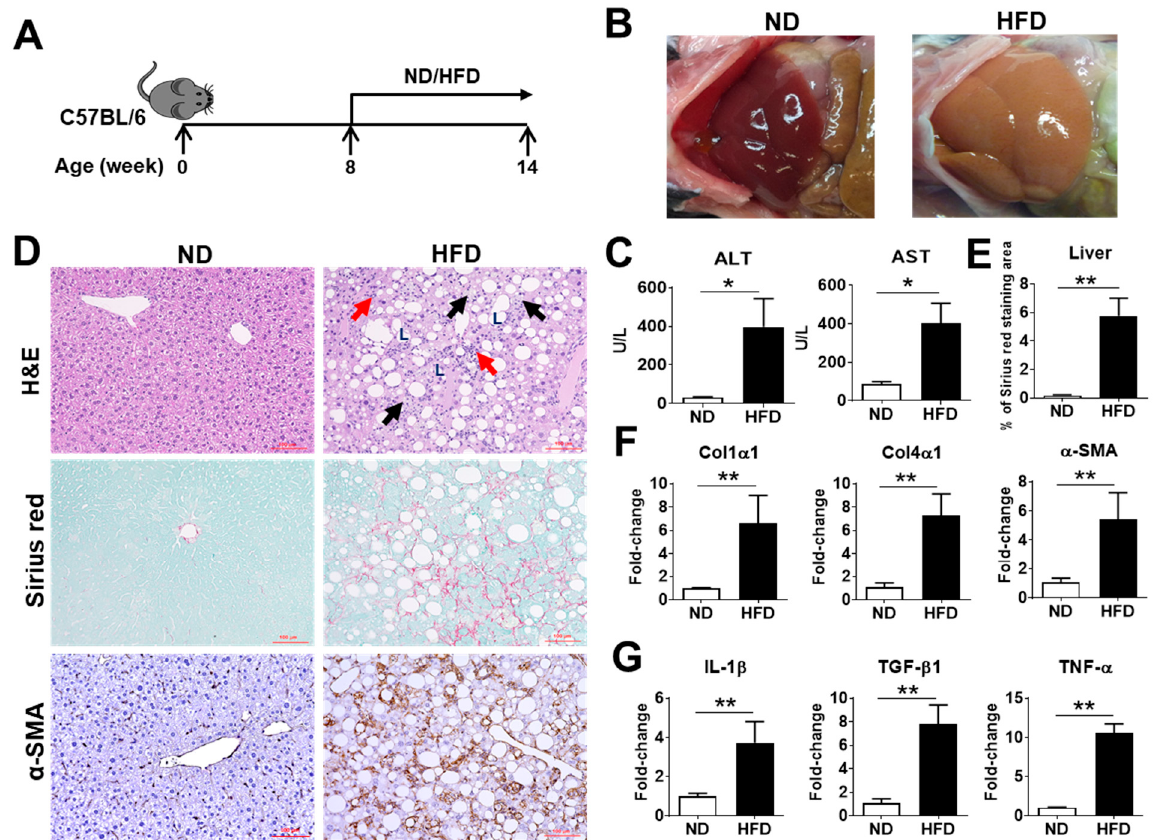
Figure 2. Characterization of a mouse NASH model. ( A ) An outline depicting HFD-induced mouse NASH. Eight-week-old wild-type (WT) C57BL/6 mice were fed a CDAHFD (abbreviating to HFD in the figures) for 6 weeks. Normal diet (ND) was used as a control. At week 14, each mouse was euthanized for the following studies. ( B ) Representative macroscopic images of livers in mice fed with HFD and ND. ( C ) Serum levels of ALT and AST in mice fed with HFD and ND. ( D ) Representative histological images of liver tissue in mice fed with HFD and ND. H&E staining showed lipid deposition (L), hepatocytes ballooning (black arrow), and inflammatory cell liver infiltration (red arrow); Sirius red staining showed the increased production of collagen (red staining); IHC showed the increased protein production of α -SMA (brown staining). Bar scale: 100 µ m. ( E ) Semi-quantification of collagen production in the livers of two groups of mice as shown in ( D ). ( F ) mRNA expression of extracellular matrix (ECM) genes in the livers. qPCR detected the increased mRNA expression of Col1 α 1 , Col4 α 1 , and α -SMA genes in the livers of the mice fed HFD compared to ND. ( G ) mRNA expression of proinflammatory cytokines in the livers. qPCR detected the increased mRNA expression of IL-1 β , TGF- β 1 , and TNF- α genes in the livers of HFD-fed mice compared to that in ND-fed mice. n = 5, error bars represent the mean ± SD. Statistical analysis of data was performed by Student’s t -test using GraphPad Prism 8 software. ** p < 0.01, * p < 0.05.